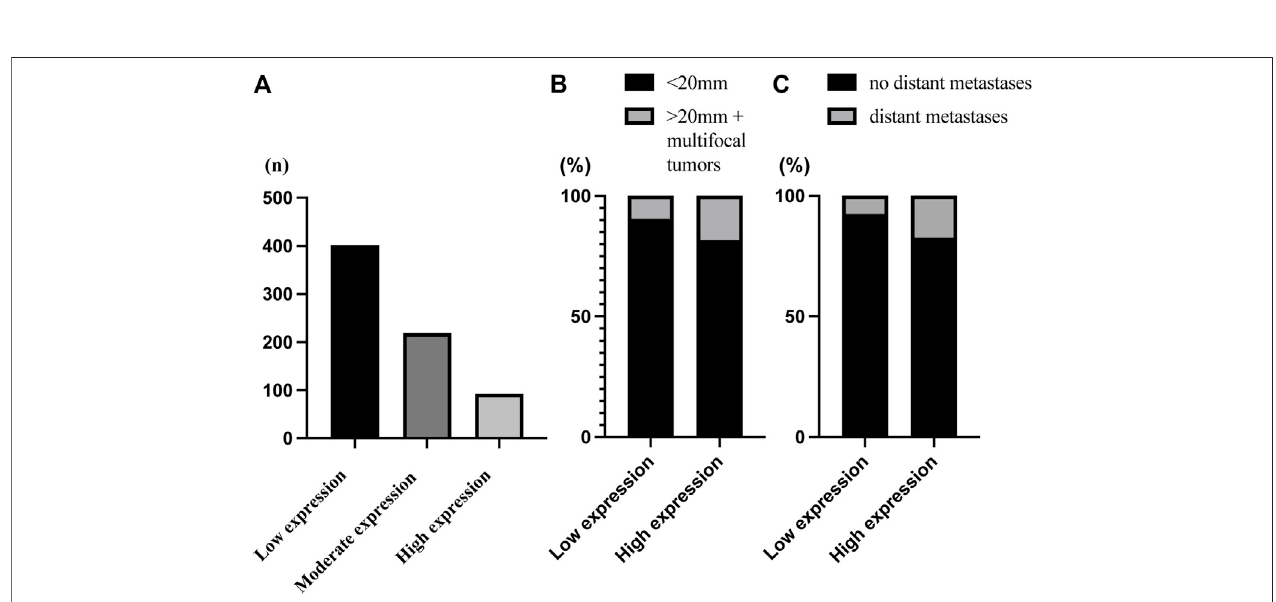
FIGURE 3 | Bar chart of the distribution of type IV collagen expression. (A) The distribution of the type IV collagen scoring groups de fi ned as low expression ( n = 402), moderate expression ( n =219) and high expression ( n = 93). (B) There wasasigni fi cantcorrelation between tumor sizeand type IV collagen expression ( p = 0.01). There was a higher proportion of small tumors (90.5%) in the low compared to the high type IV collagen expression group (81.7%), and a higher proportion of large tumors ( > 20 mm or multifocal tumors) (18.3%) in the high expression group compared with the low type IV expression group (9.5%). (C) There was a signi fi cant correlationbetweendistantmetastasis andtypeIV collagenexpression( p =0.002).Therewasahigher proportionofdistantmetastasis (17.2%)inthehighcompared to the low type IV collagen expression group (7.4%), and a higher proportion of no distant metastasis in the low (92.6%) compared to the high type IV collagen expression group